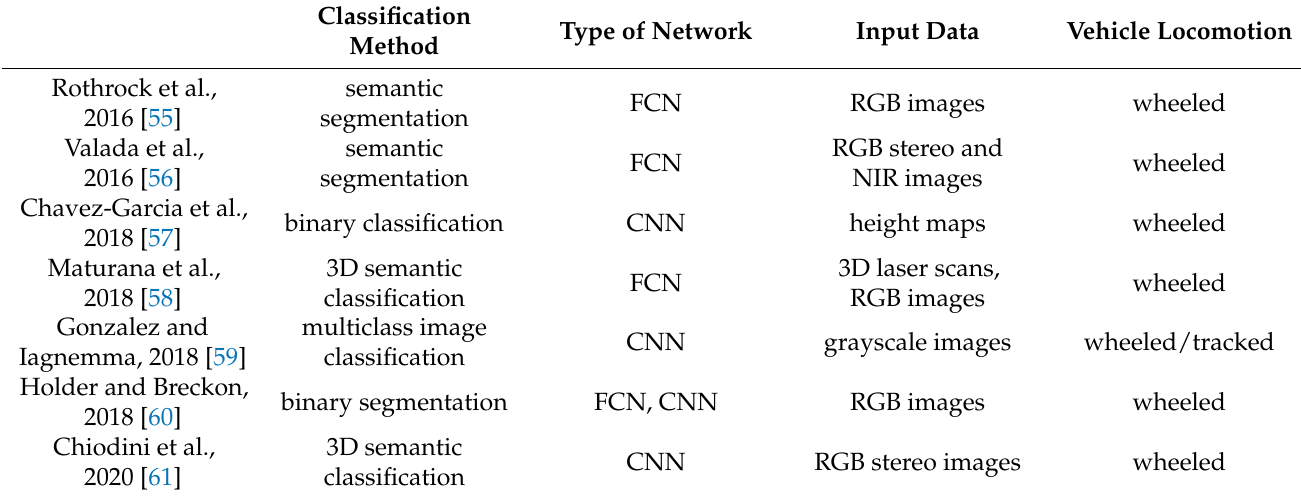
Table 4. Works on classification of terrain type with deep